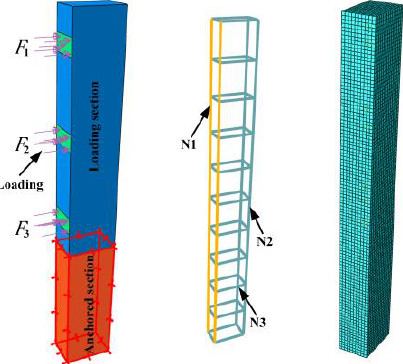
Figure 22. Three-dimensional numerical model and loading diagram of model